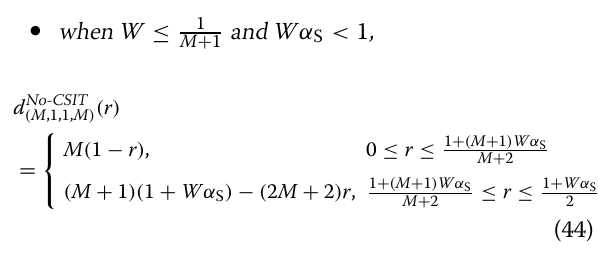
Fig. 10, the DMT without CSIT w/wo side channel is given when W = 1 and α S = M . Compared with the 2 M + 1 2